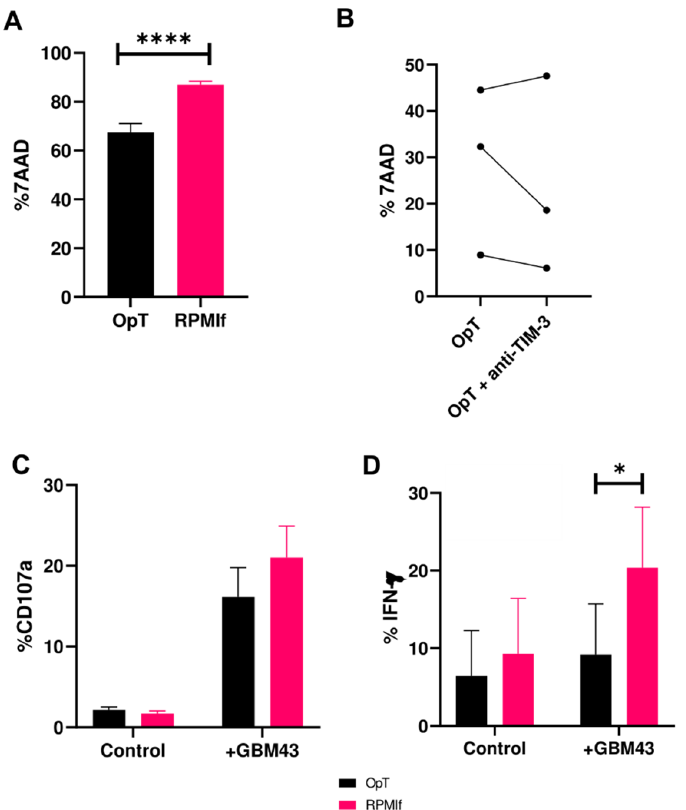
Figure 5. Functional potential of human NK cells against GBM43 cells under varying stimulation conditions (mean ± SEM). Cytotoxicity of human NK cells after 4 h co-culture with GBM43 cells at an E:T ratio of 2.5:1 following stimulation in either ( A ) OpT or RPMIf medium ( n = 3 donors); and ( B ) following TIM-3 blockade stratified for three individual donors ( n = 3); ( C ) CD107a and ( D ) IFN- γ production ( n = 3) by NK cells stimulated in OpT or RPMIf in response to GBM43 cells. * p < 0.05 and **** p < 0.0001.